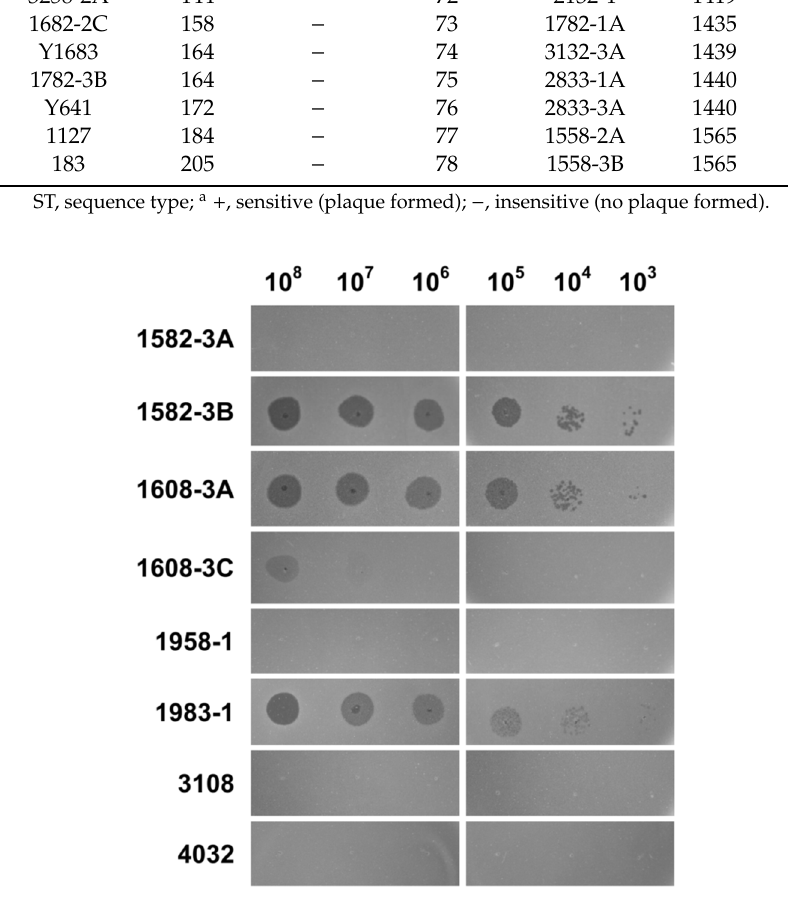
Figure 7. The spot assay on ST4 B. cereus strains by DLc1 with stepwise dilutions. Four strains (1582-3B, 1608-3A, 1608-3C, and 1983-1) show sensitive response, and other four strains (1582-3A, 1958-1, 3108, and 4032) present insensitive response.